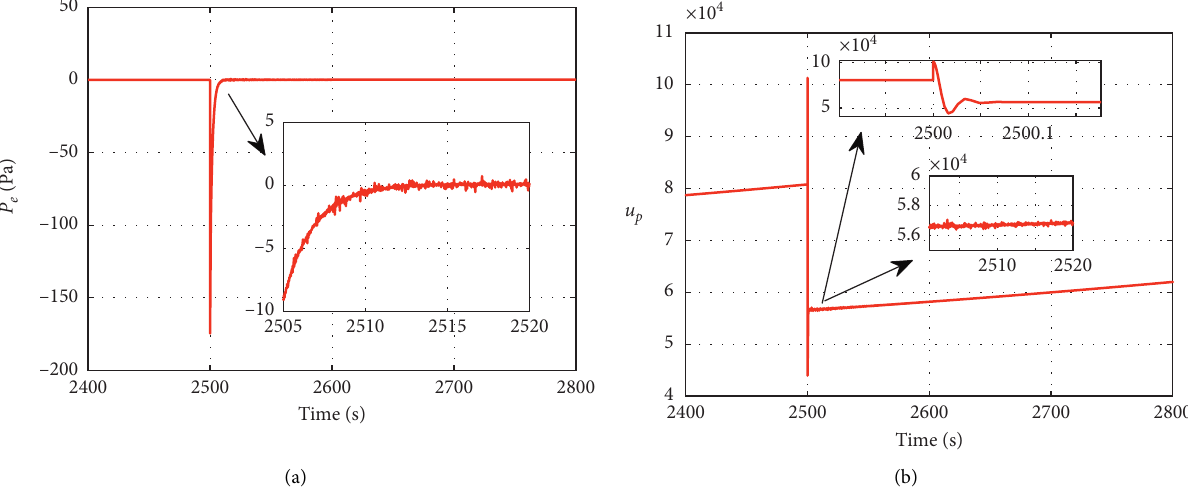
Figure 14: Pressure error and control input of simultaneous double faults after reconfiguration.